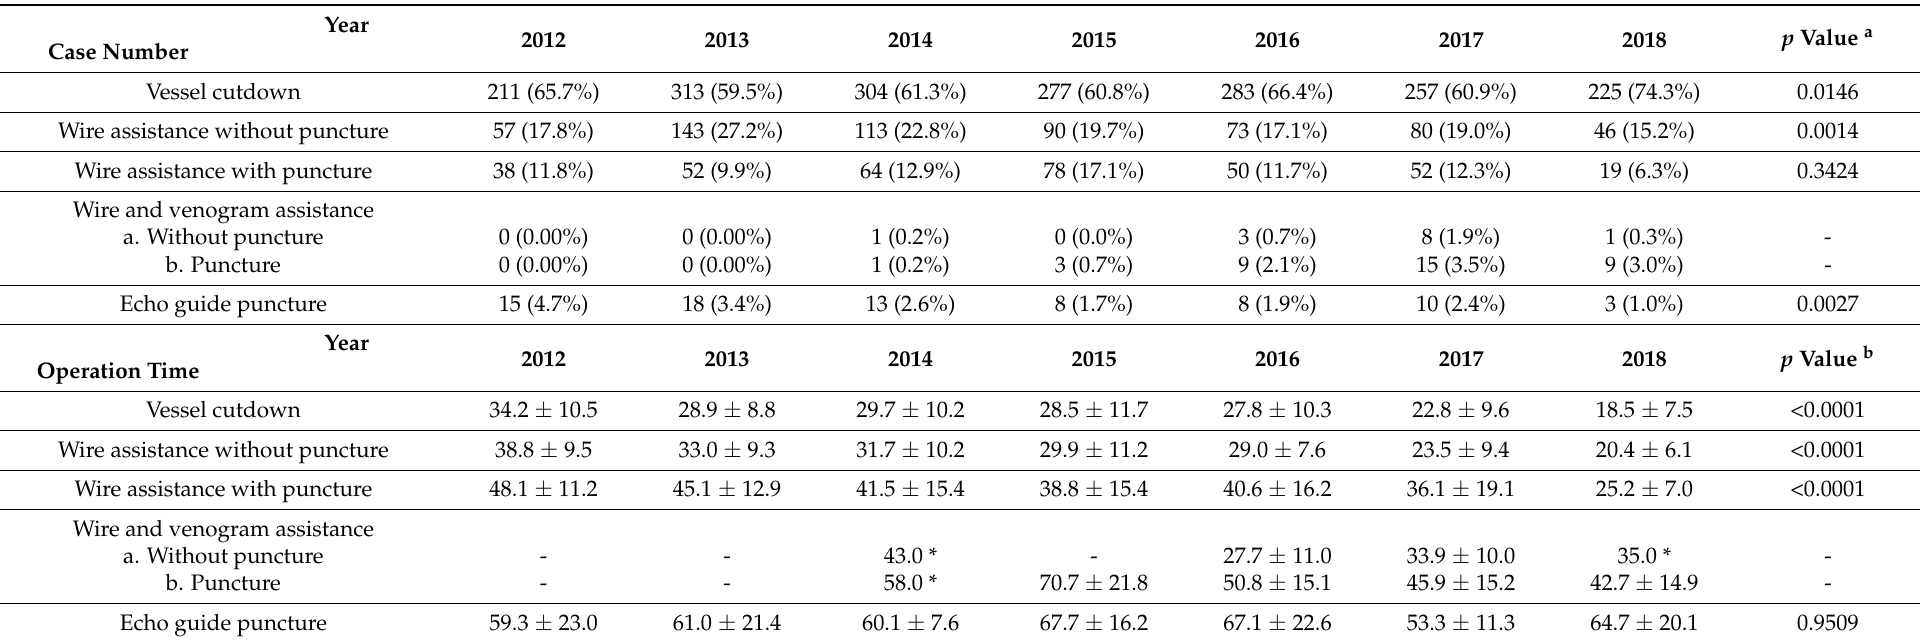
Table 3. Evolution of operation method and operative